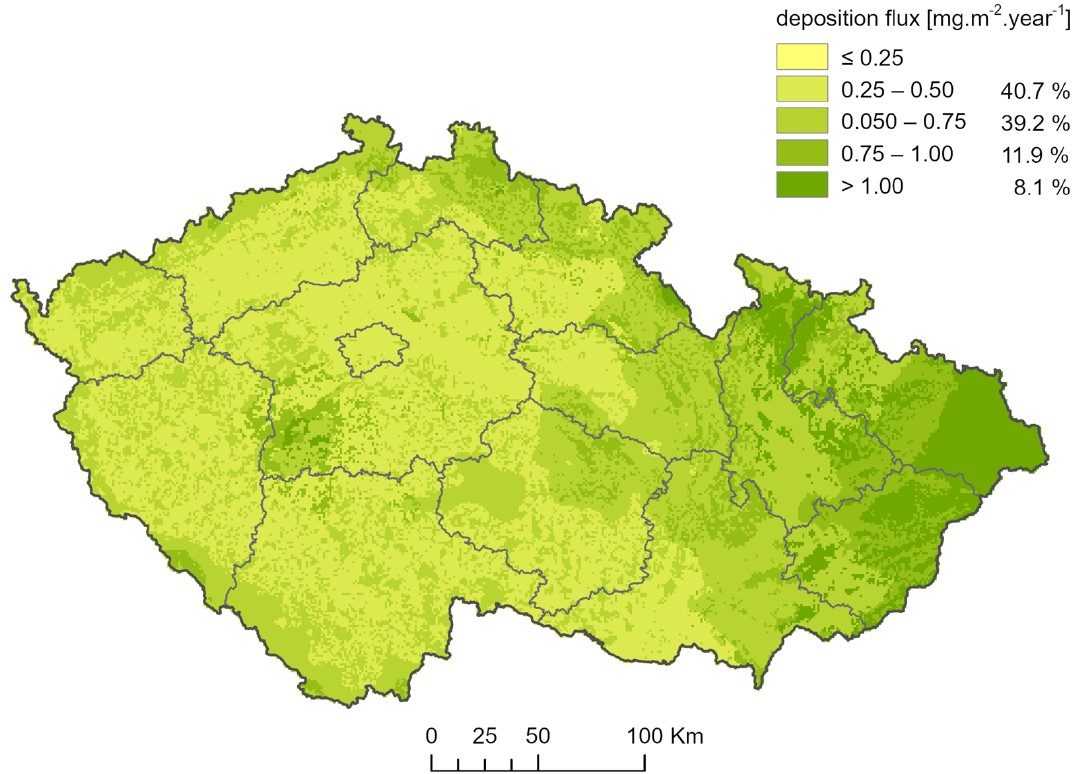
Figure 6. Spatial pattern of total Pb deposition, 2019.